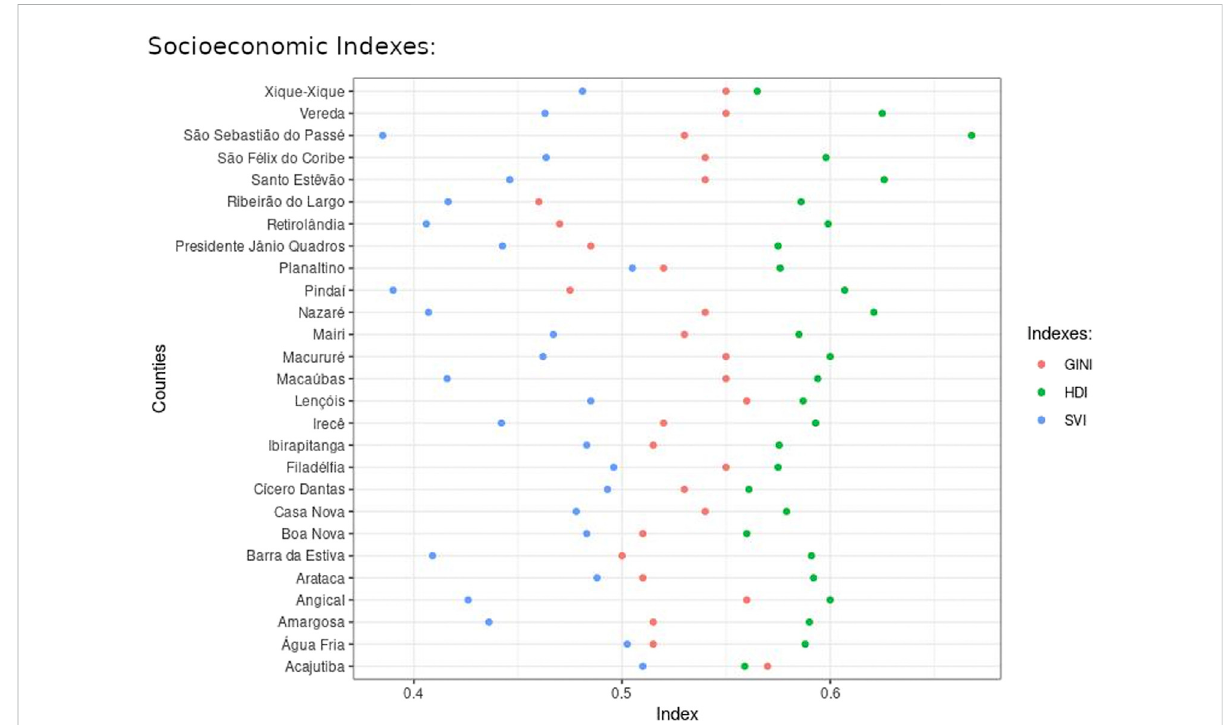
FIGURE 5 Population universe of clusters identifying the total number of municipalities in each cluster.